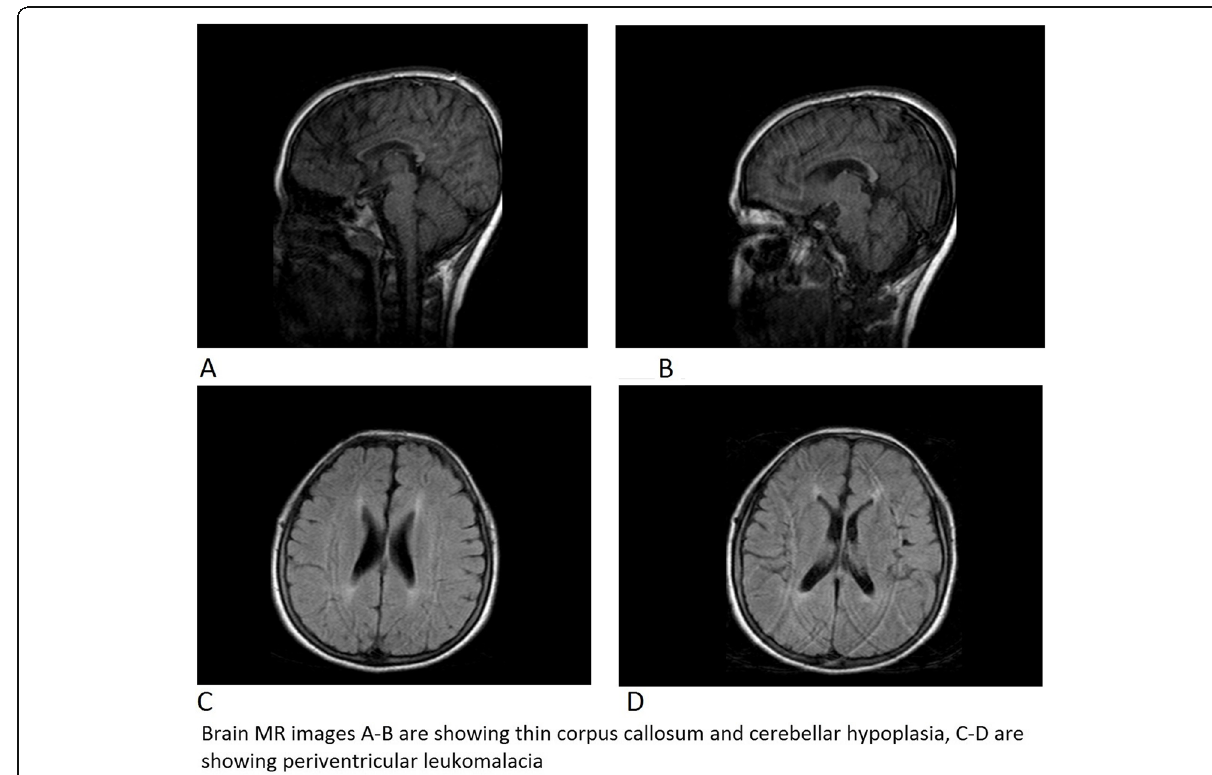
Fig. 2 Brain MRI findings of the